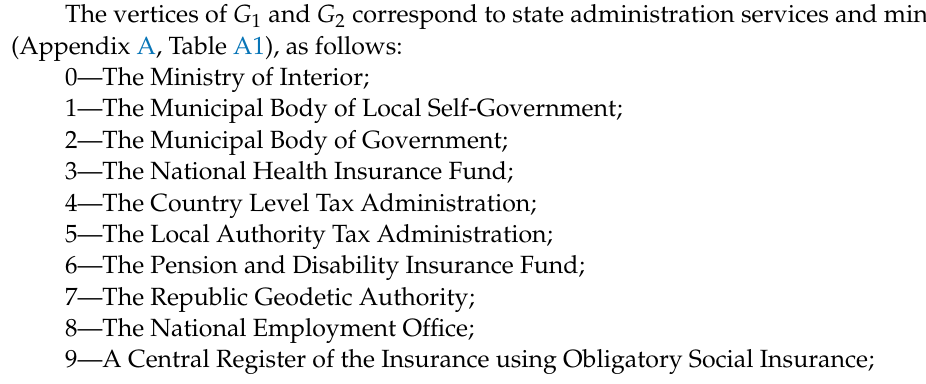
Figure 4. Digraph G 2 — the proposed procedure in the presented